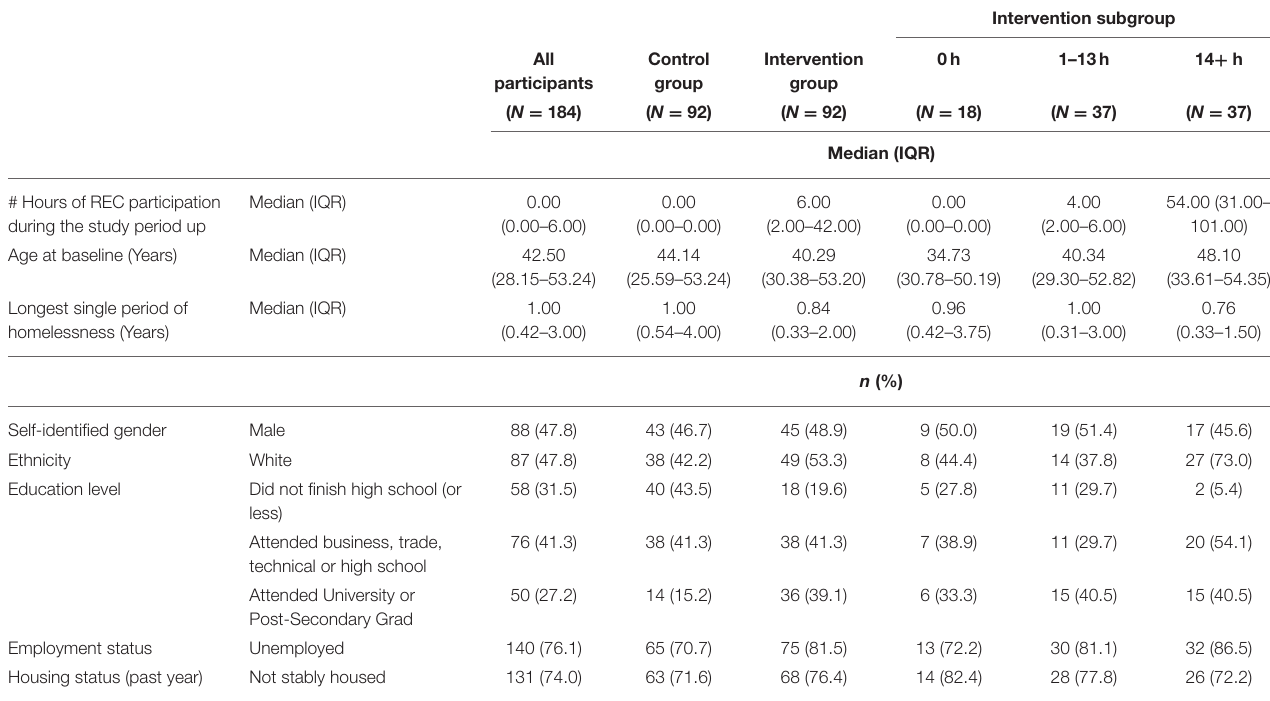
TABLE 2B | Sociodemographic characteristics for the total sample and for the intervention subgroups divided by number of hours of REC participation over the 12 month study period.